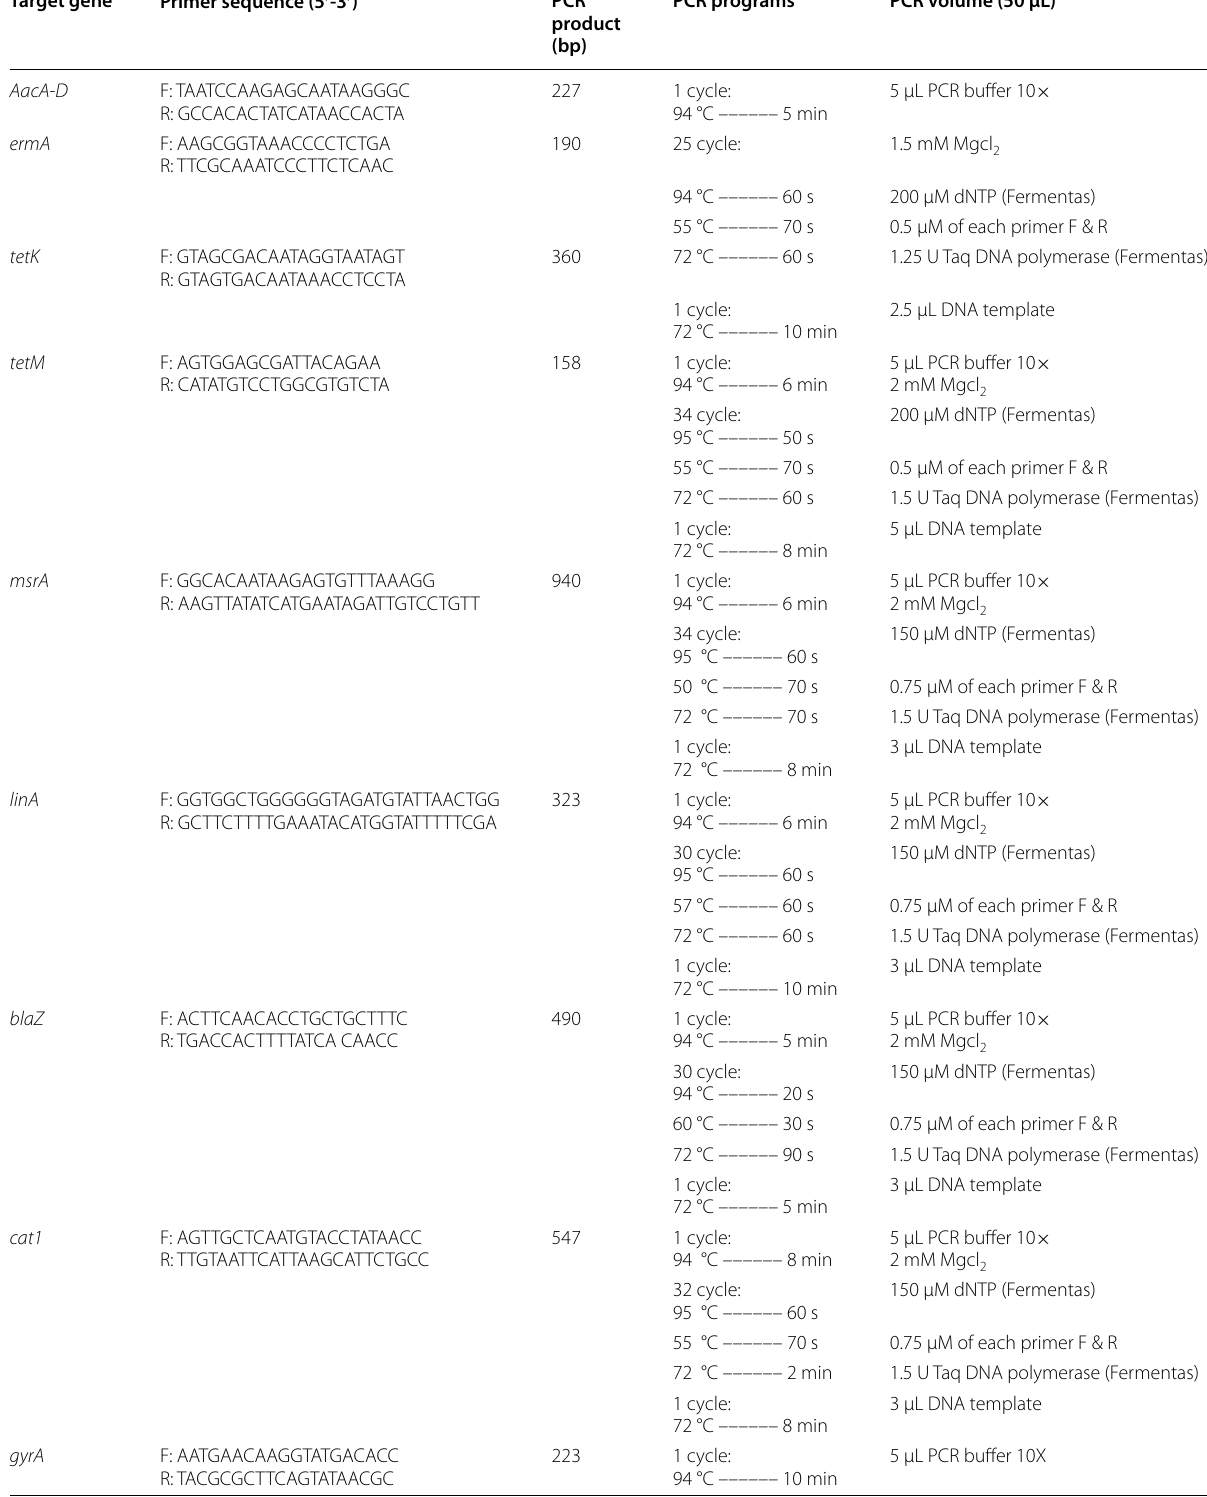
Table 5 PCR circumstances used for genotypic assessment of antibiotic resistance [48, 55–61] Target